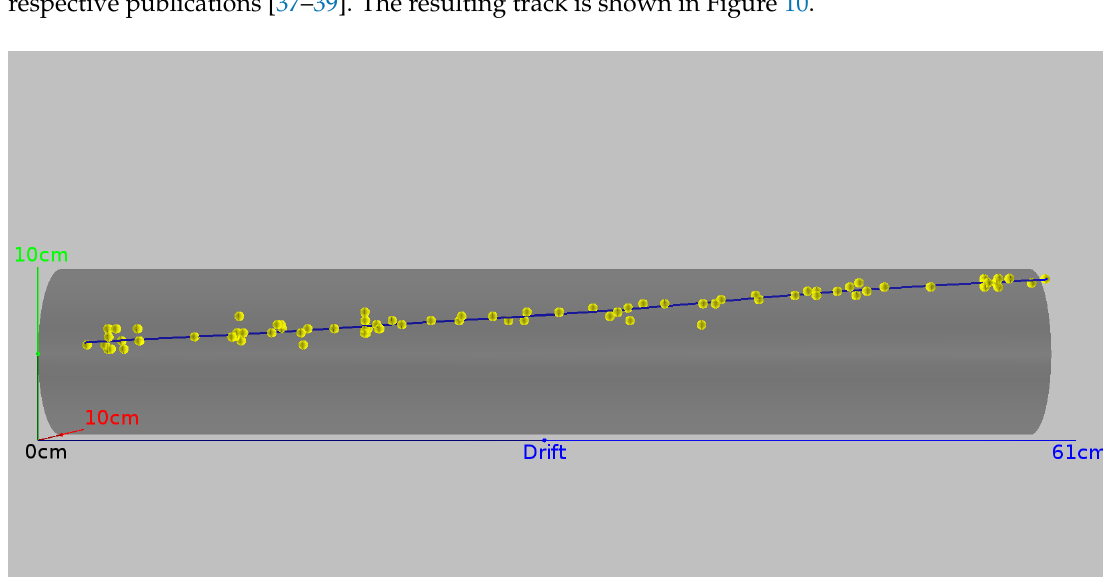
Figure 10. Track fitted by the Kalman filter. The TPC volume is shown in faint grey. The passing particle is most likely a cosmic µ entering from the left (the same event as in Figures 6–9). Drift direction is from right to left. The yellow points are the input to the Kalman filter, the accepted 3D hits from the principal component analysis. Blue is the output, a fitted track taking into account ionization losses and multiple scattering in